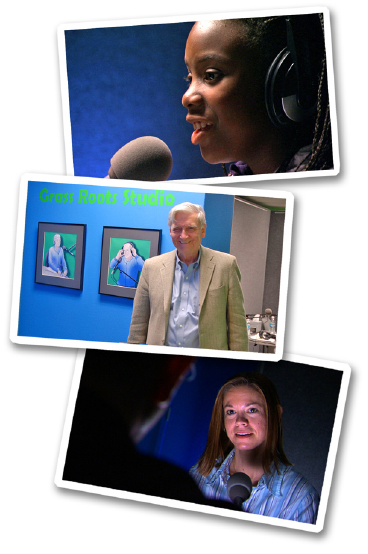
Figure 1. Talking Science in the Grass Roots Studio—Ask A Biologist podcast co-host and guests: (from top to bot- tom) future scientist Taylor Cheatham (Wickedly Cool Plants interview), Ed- ward O. Wilson (Science Rock Star interview), and rising star microbiolo- gist Shelly Haydel (Mud Science - Heal- ing with Clays interview). Photos: Actual Films and CJ